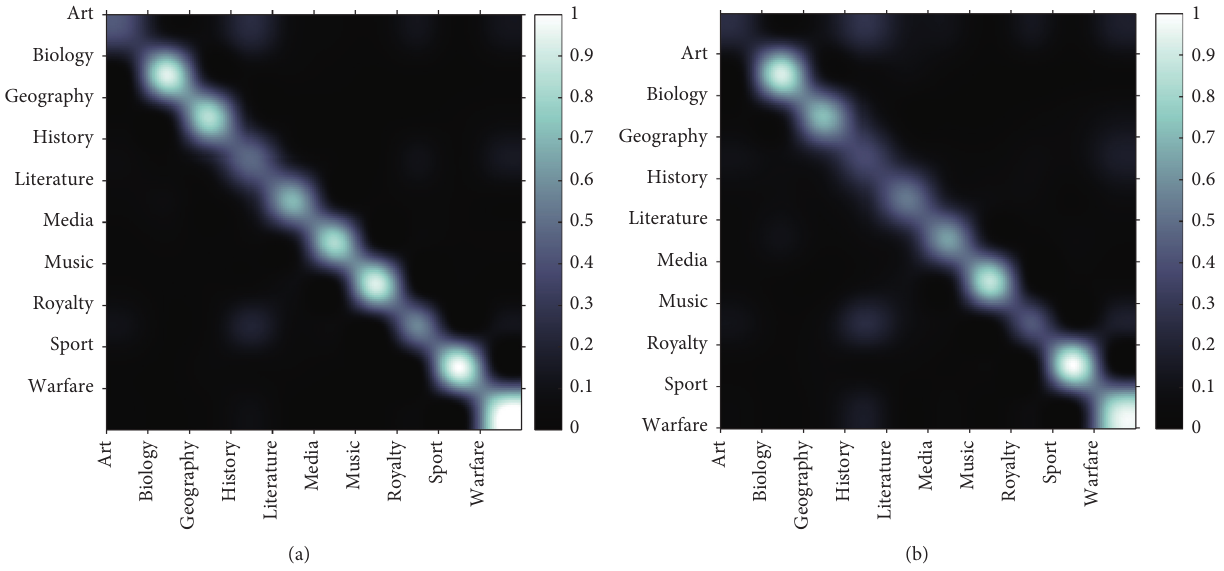
Figure 5: Class-level confusion matrices computed by the (a) image query and (b) text query on wiki-W.